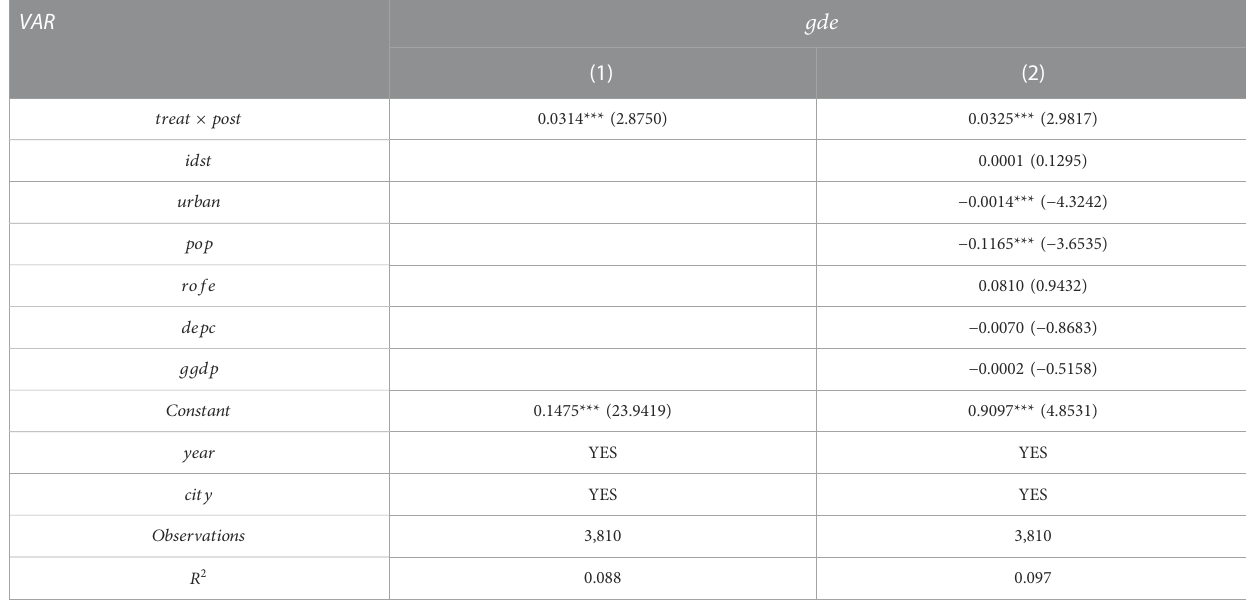
TABLE 2 Effects of the energy-consuming right trading policy on the ef fi ciency of urban green development. VAR